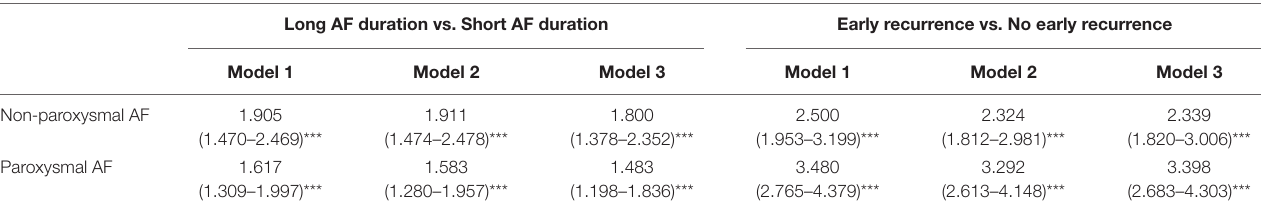
TABLE 2 | Hazard ratios (HRs) for the association between long atrial fibrillation (AF) duration and ER with AF recurrence. Long AF duration vs. Short AF